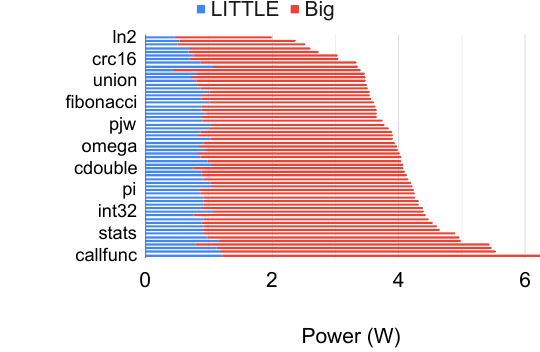
Figure 2. Power consumption from LITTLE and big clusters for every stress-ng